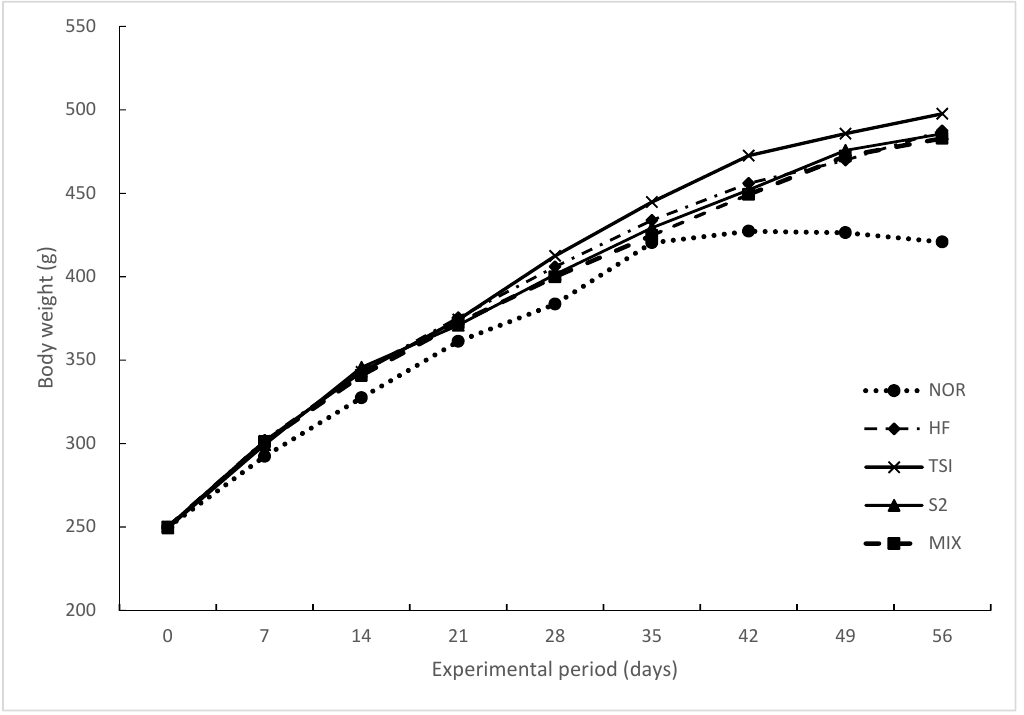
Figure 1. Changes in the body weight gain of rats upon oral treatment for 8 weeks.